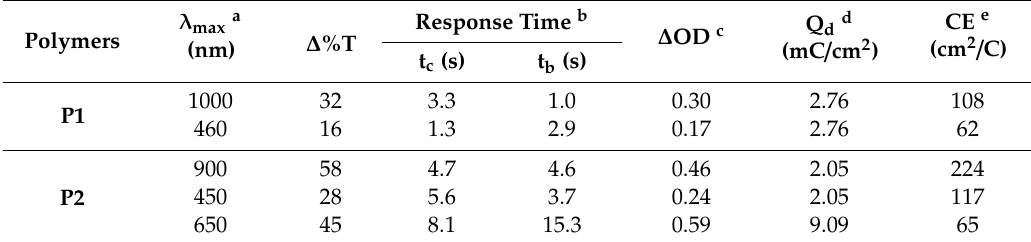
Table 2. Electrochromic properties of the polymer films.